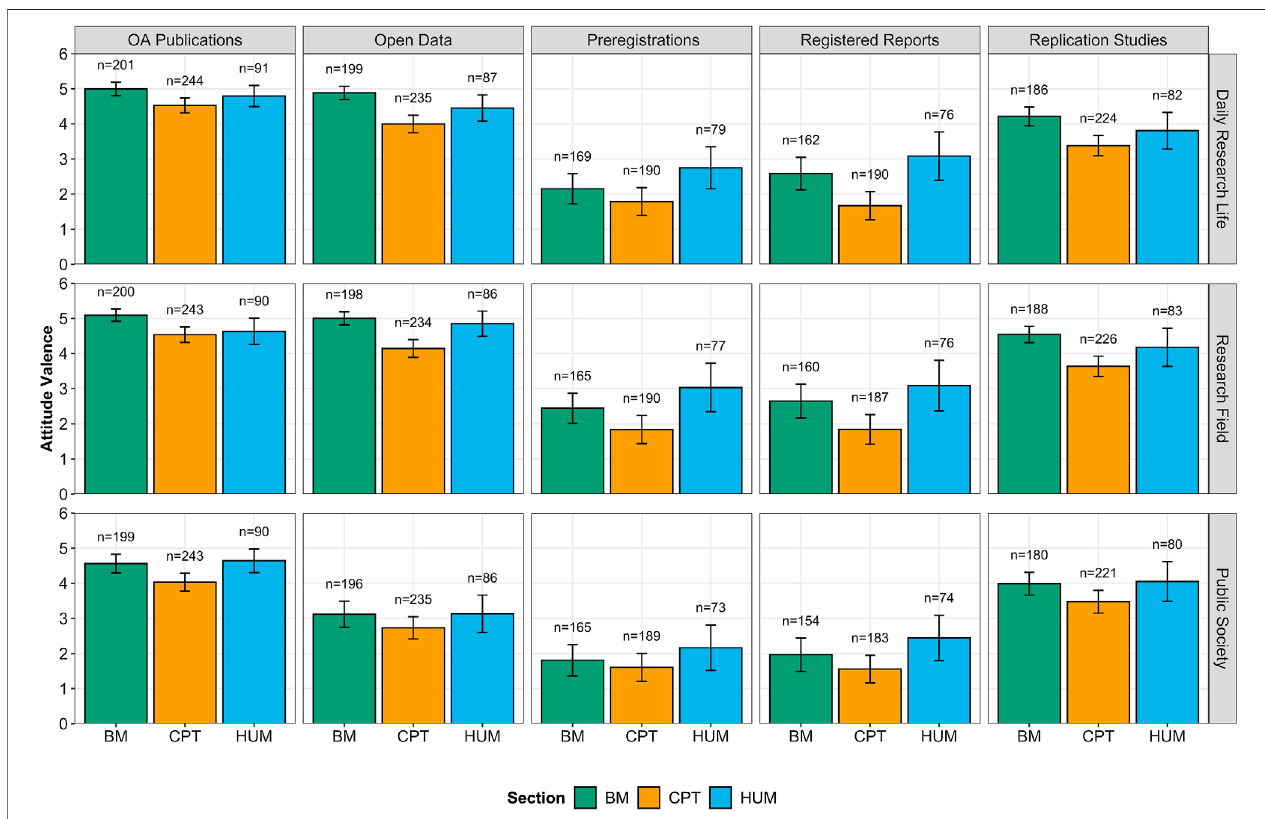
FIGURE 2 | Attitude valence of ECRs toward OS practices from different perspectives (i.e., daily research life, research fi eld, and public society) aggregated by sections (BM: biology and medicine, CPT: chemistry, physics, and technology, and HUM: Humanities). Error bars represent 95% con fi dence intervals (CIs).